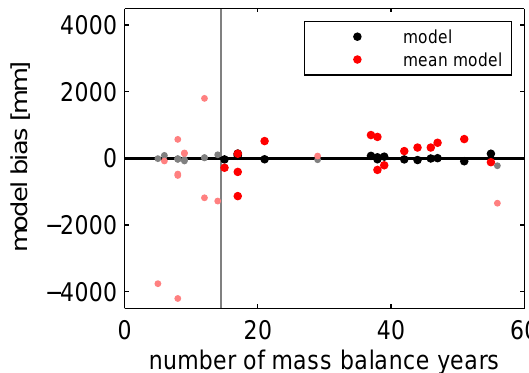
Fig. 8. Model bias as a function of the number of MB measured . Black (red) dots are the values of the glaciers accepted into the final set, gray (light red) dots are those of the rejected glaciers. Red dots show the result of the mean model. The gray vertical line indicates the minimum number of mass balances necessary to yield robust results for a optimized and µ optimized